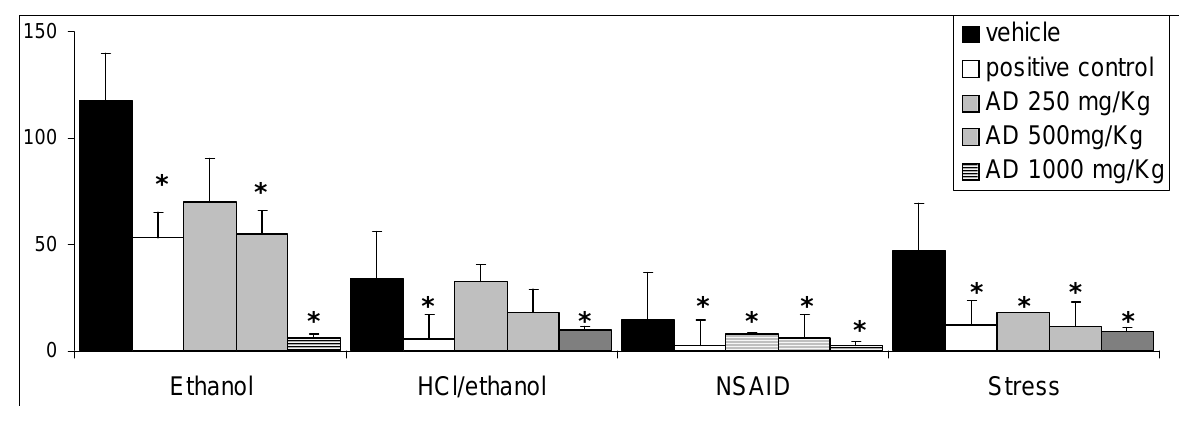
Figure 1 . Effects of different doses of aqueous decoction (AD) of Mangifera indica leaves on models of gastric lesions induced in mice and rats (mm).